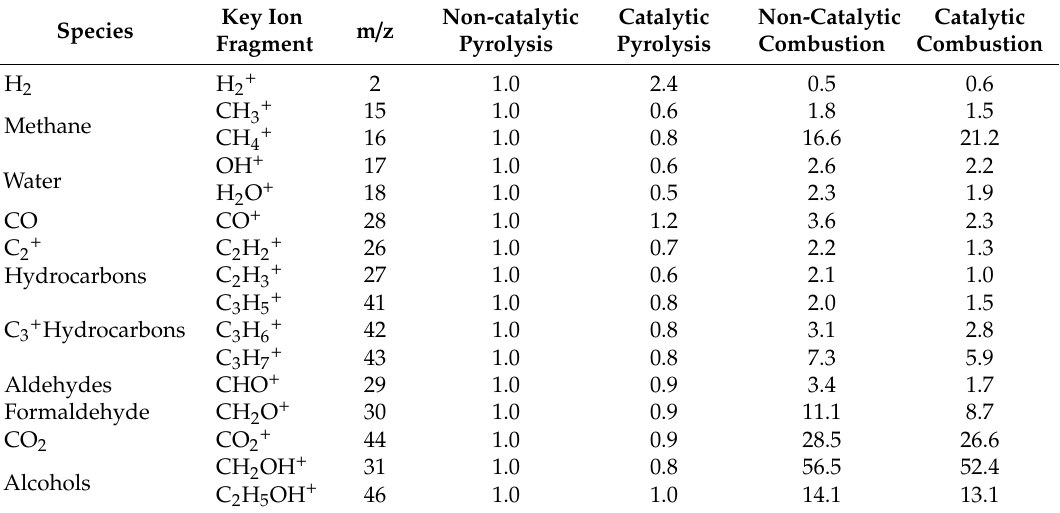
Table 3. Relative proportion of key species with respect to non-catalytic pyrolysis. Key Ion Species Fragment